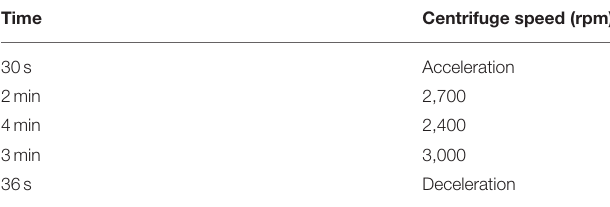
TABLE 1 | Centrifugation